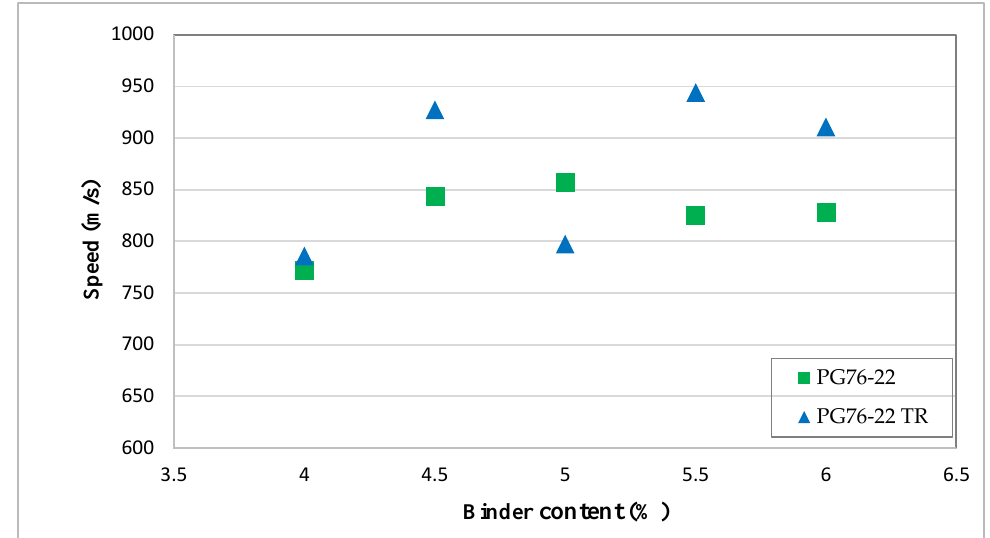
Figure 4. Wave speed trend with asphalt binder content for PG74-22 specimens.